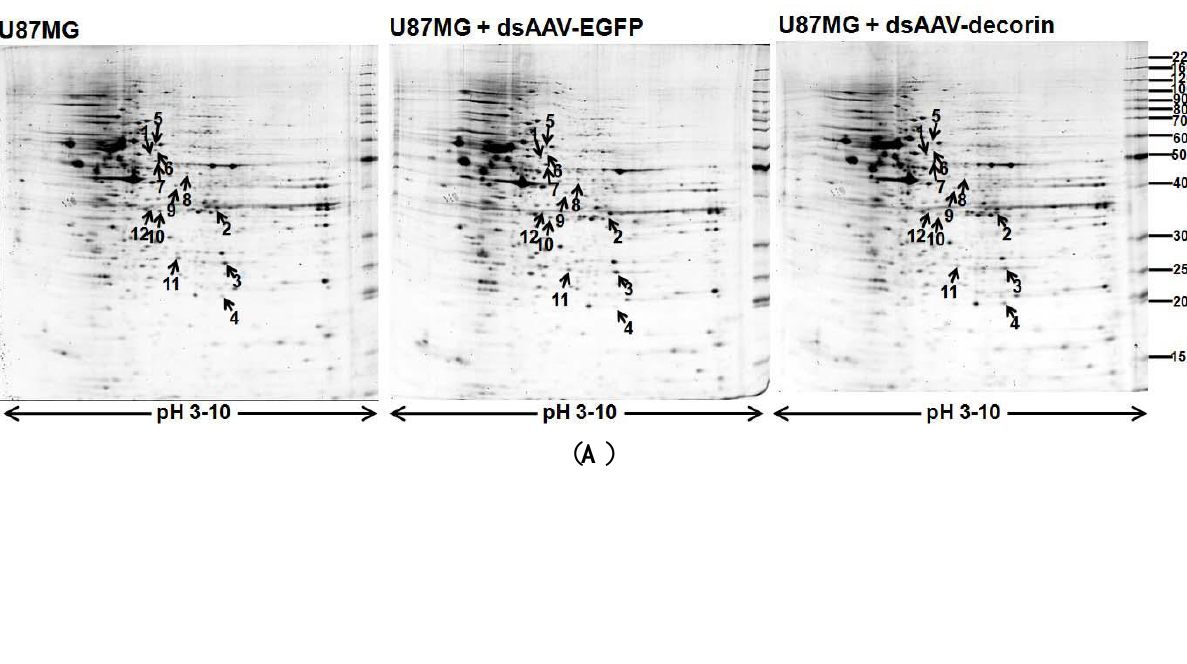
U87MG + dsAAV-EGFP, and U87MG + dsAAV-decorin cells. ( A ) The